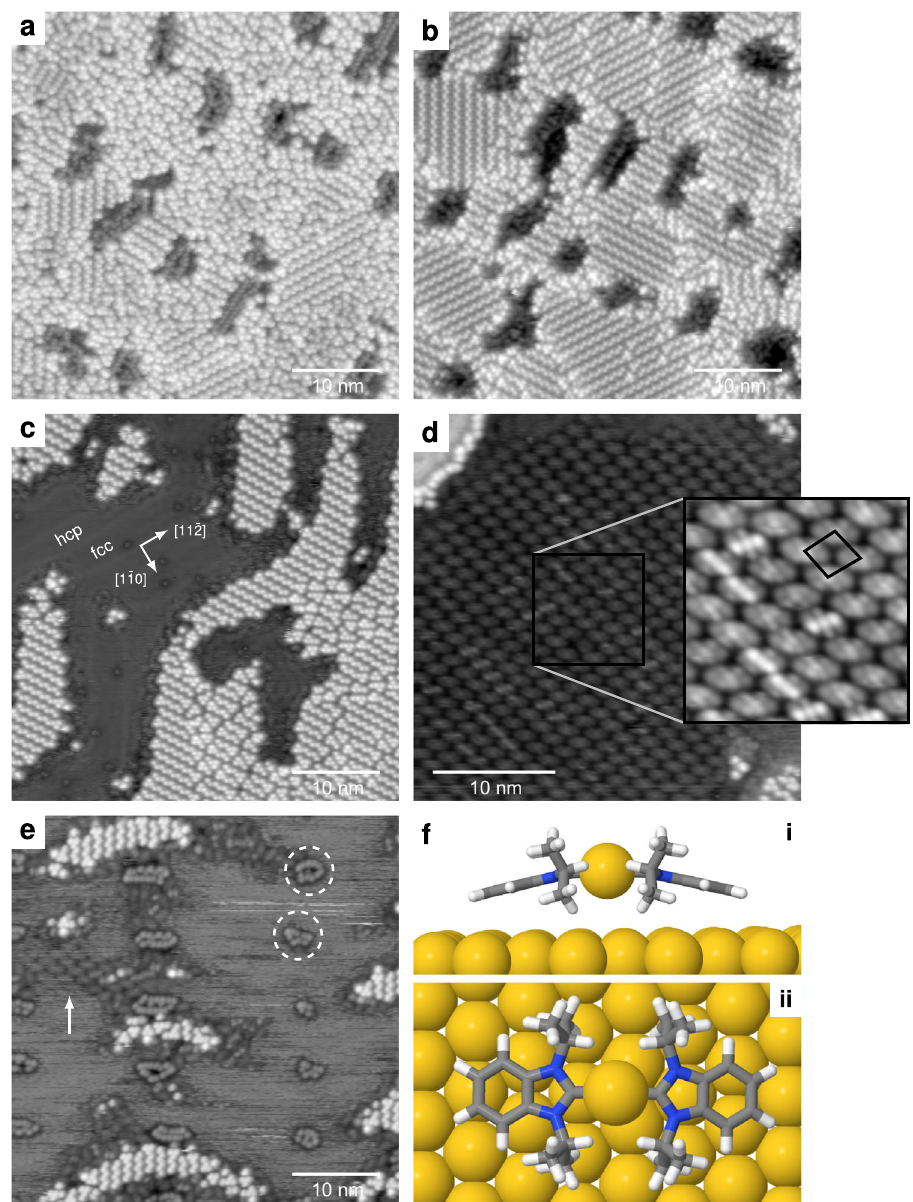
Fig. 4 The effect of coverage and temperature on NHC iPr adsorption and self-assembly on Au(111). a Au(111) surface saturated with upright NHCs (20pA, 100mV, 45.0×45.0nm 2 ). b Subsequent low-temperature annealing produces highly ordered structures (50°C, 20pA, 100mV, 45.0×45.0nm 2 ). c The coverage of upright species decreases when heating a saturated monolayer to 100°C (20pA, 100mV, 45.0×45.0nm 2 ). d Large (NHC) 2 Au complex arrays form on Au(111) after heating to high temperature (140°C, 30pA, 100mV, 32.0×32.0nm 2 ). e (NHC) 2 Au complexes form on room-temperature prepared fi lms at low coverage and self-assemble into small, mobile arrays (20pA, 100mV, 45.0×45.0nm 2 ). f Side and top views of the (NHC) 2 Au